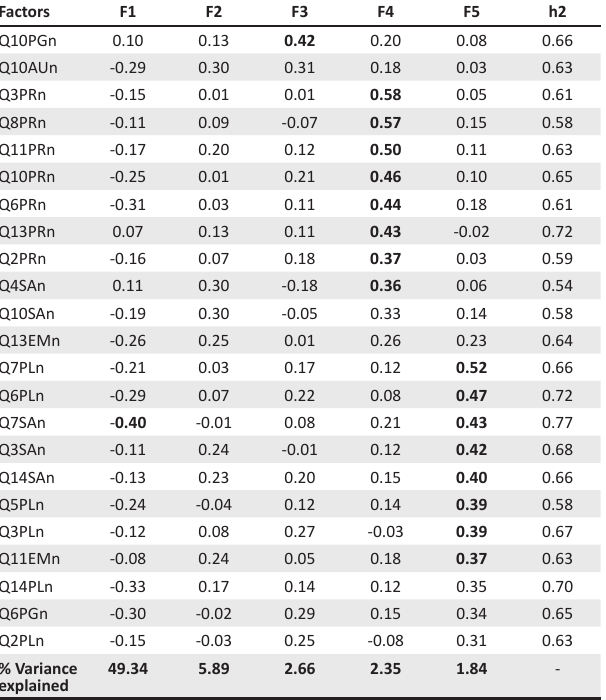
TABLE 2 (Continues...): Maximum likelihood analysis with direct oblimin rotation pattern matrix for the Ryff Scales of Psychological Well-Being. Factors